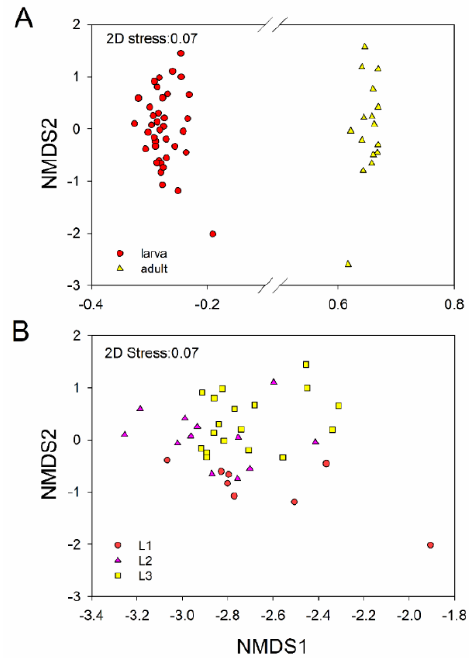
Figure 4. Non-metric multidimensional scaling (NMDS) plot showing bacterial community composition